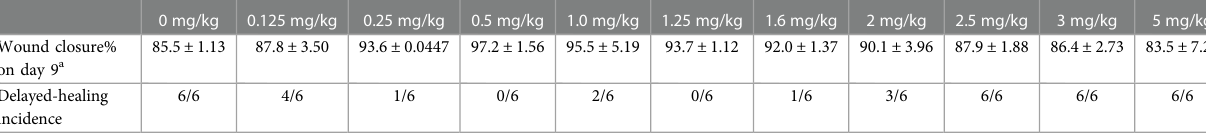
TABLE 2 Different doses of dexamethasone in septic mice (wound closure on day 9).